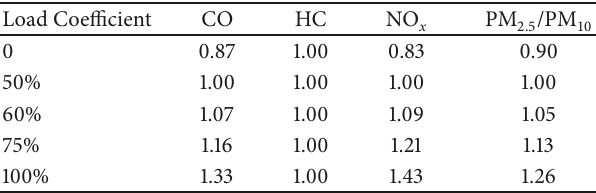
Table 7: Gasoline vehicle load correction factor.